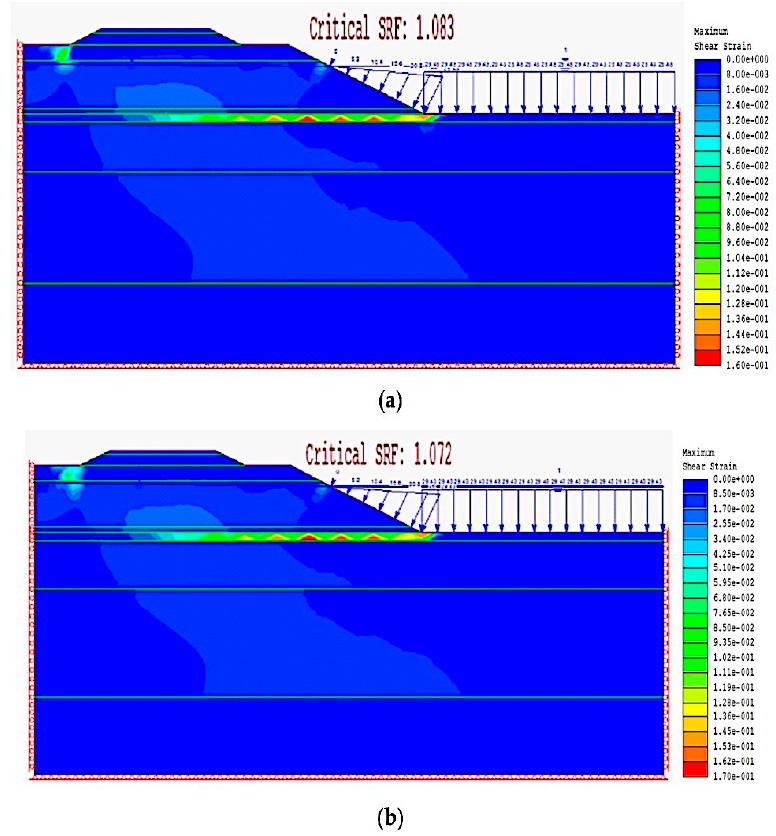
Figure 14. Colored contour shading of shear strain at SLR by ( a ) 26.70 cm and ( b ) 51.30 cm.